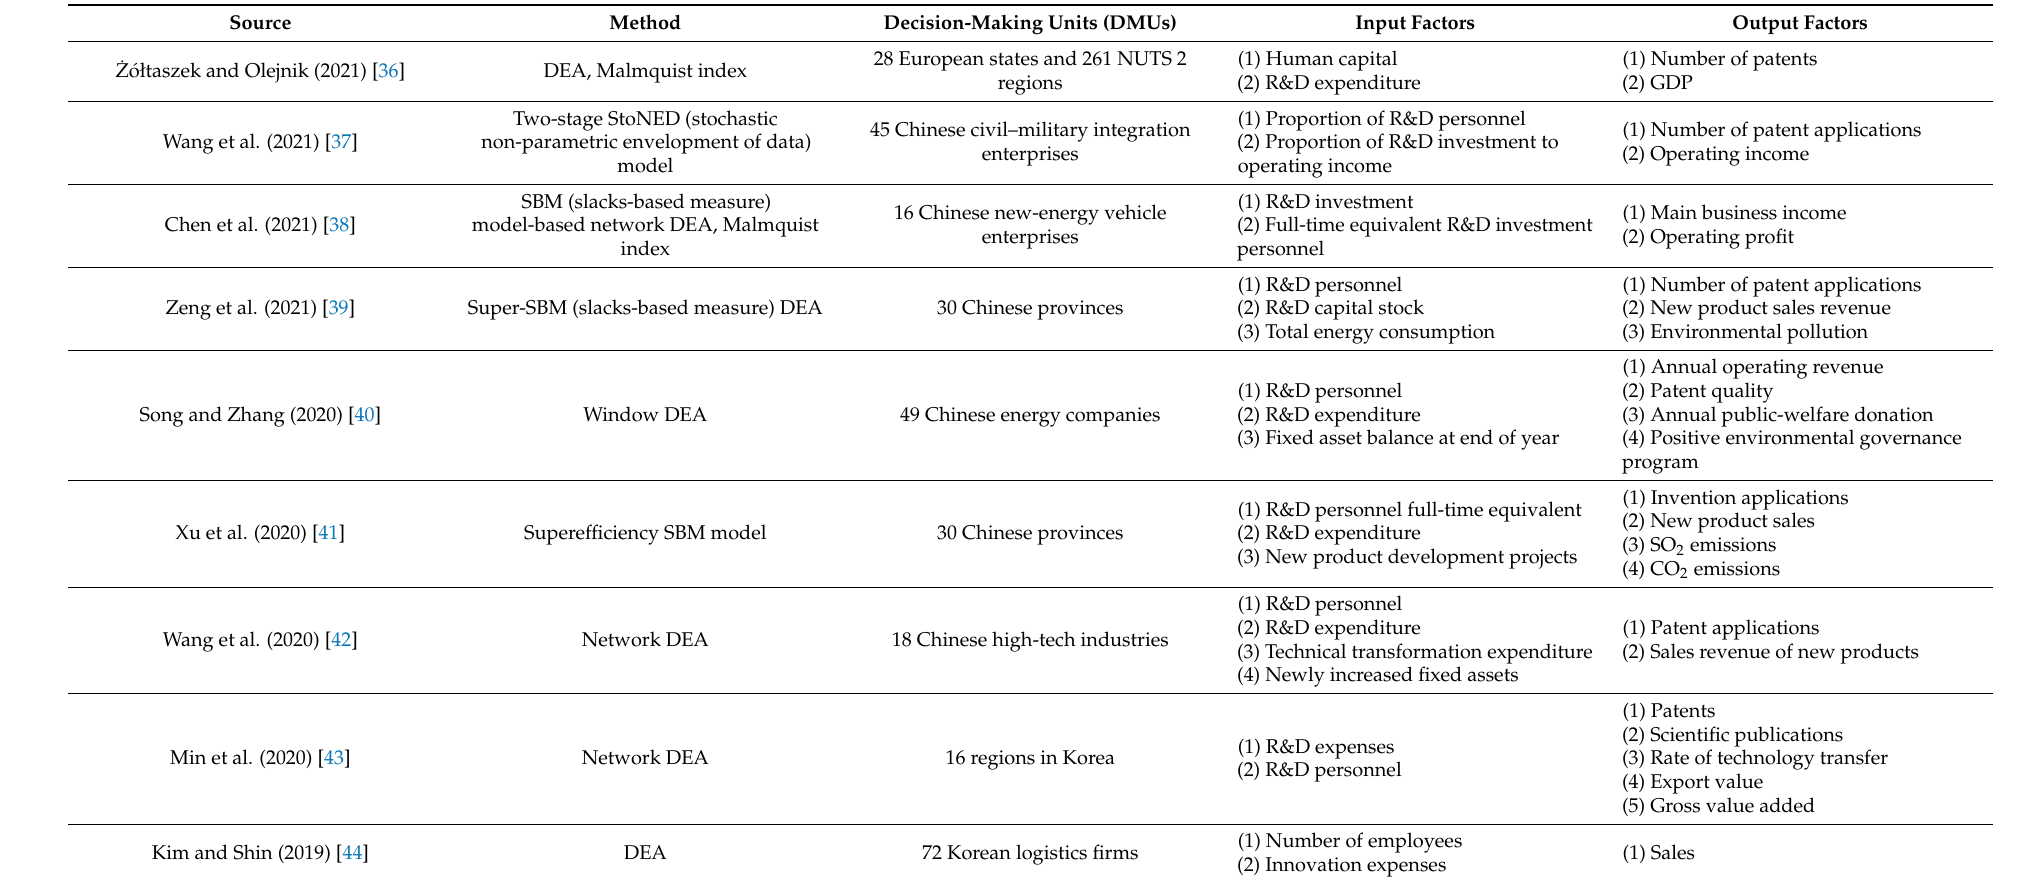
Table 1. Recent studies on innovation